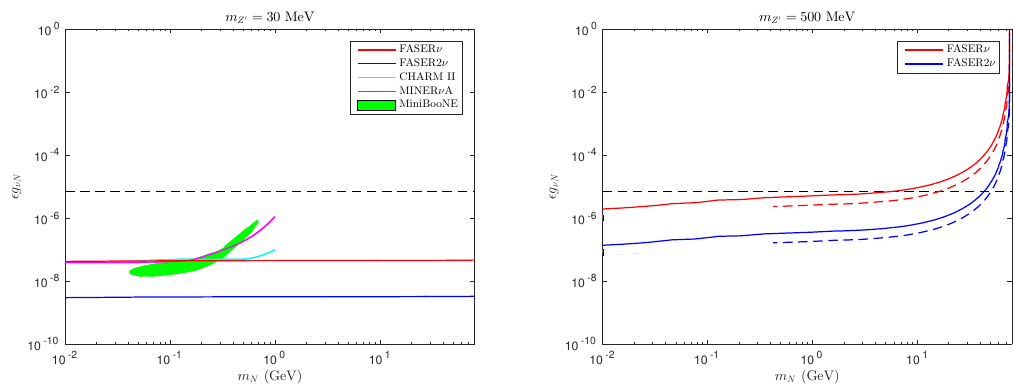
Figure 3 . Constraints on (cid:15)g νN vs. m N . In the left (right) panel, we have taken m Z 0 equal to 30 MeV ( 500 MeV ). The solid red curves correspond to the bound that FASER ν can obtain during run III of LHC with events originating inside the detector (i.e., taking N HESE = 1 ). The dashed red curve in the right panel shows the same bound once events originating inside the rock are included (i.e., taking N HESE + N through-going = 1 ). The blue curves marked with FASER2 ν show the bounds that can be achieved by future upgrades of FASER ν with two hundred times more data. The dashed curves are clipped at m N = 4 m µ as for lighter N , the signal of µ ¯ µµ ¯ µ for through-going muons cannot be obtained. The cyan and magenta curves correspond to the current constraints from CHARM II and MINER ν A [34]. The green area shows the solution to the MiniBOONE anomaly presented in [8]. The dashed black lines show 7 × 10 − 6 which is a combination of the bound (cid:15) < 7 × 10 − 4 from BABAR [23] and setting g νN = 10 − 2